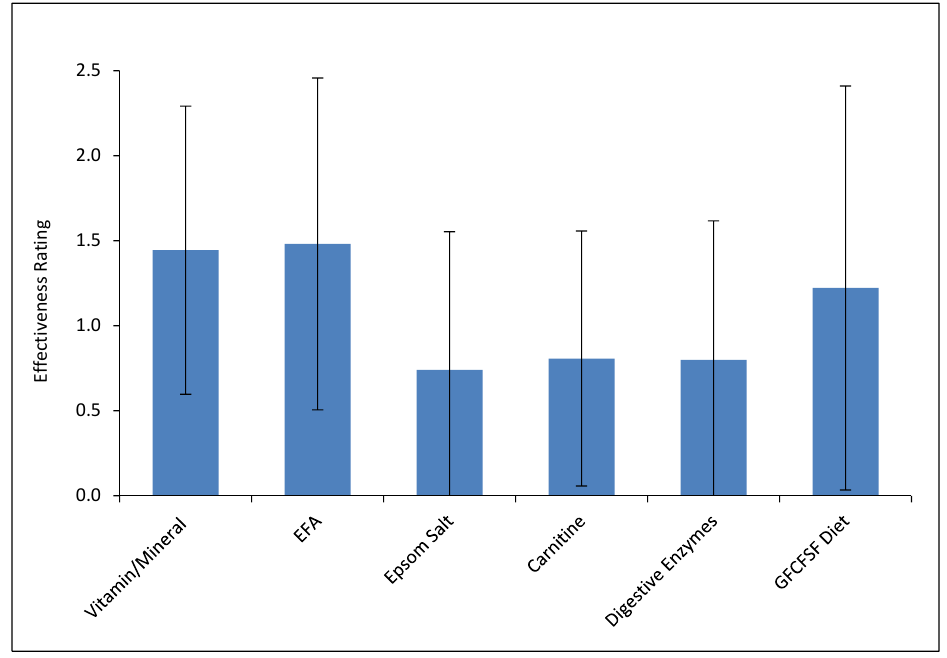
Figure 14. Effectiveness of each treatment as rated by parents. This is rated on a scale of − 3 (much worse) to 0 (no effect) to 1 (slightly better) to 2 (better) to 3 (much better). Error bars represent standard deviations.